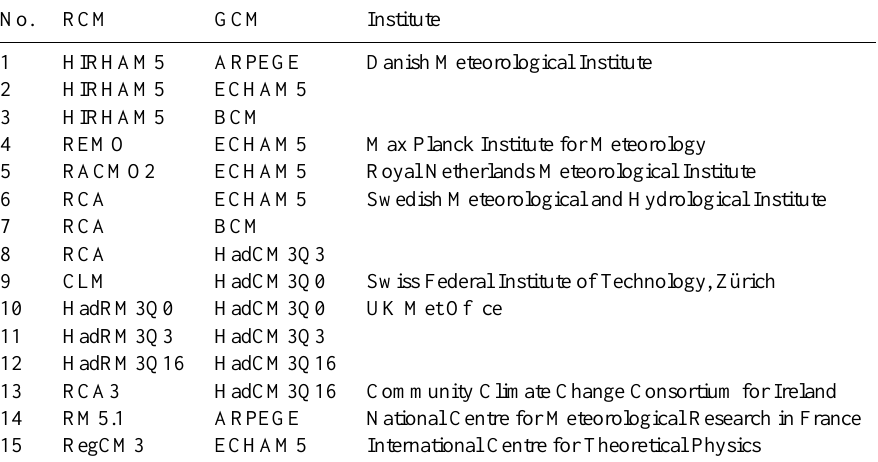
Table 1. List of RCMs used in this study, driving GCMs and source of the RCMs. No. RCM GCM Institute 1 HIRHAM5 ARPEGE 2 HIRHAM5 ECHAM5 3 HIRHAM5 BCM 4 REMO ECHAM5 5